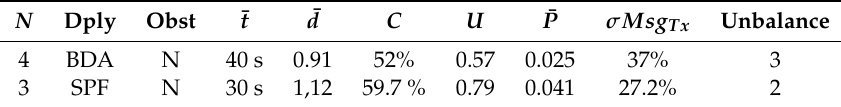
Table 2. Deployment of real mesh networks using BDA and SPF.